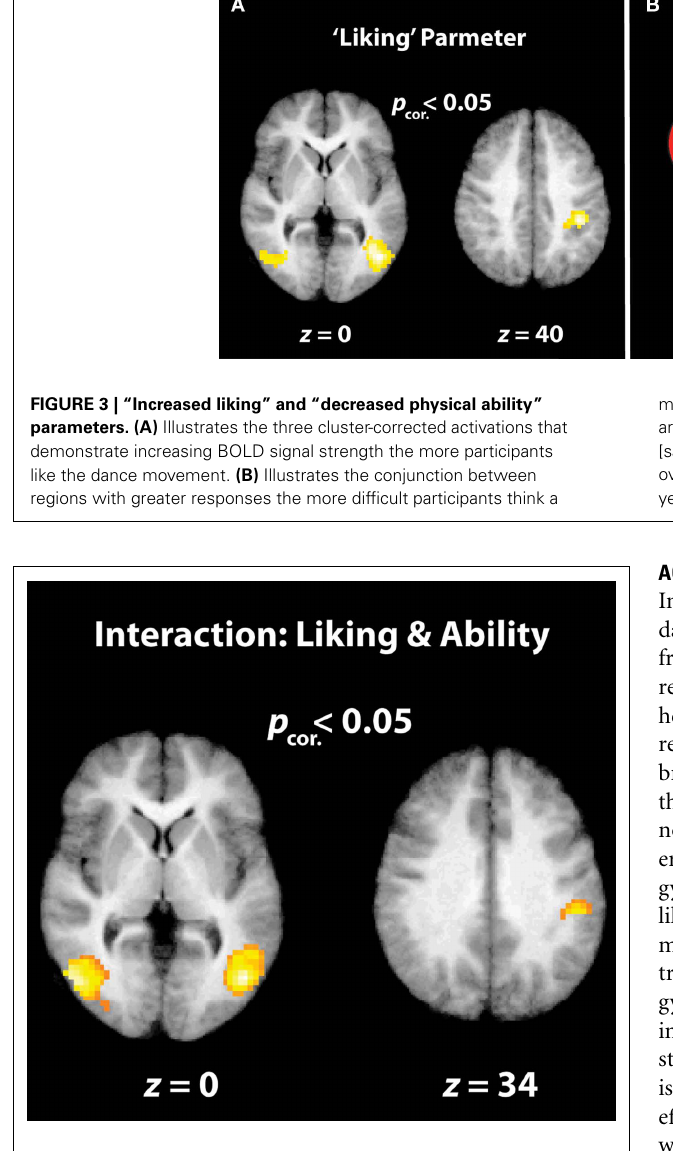
FIGURE 4 | Interaction between “liking” and “physical ability” parameters. The parietal and visual brain regions illustrated here are cluster-corrected activations that are active when participants watch dance movements that they rate as being highly enjoyable to watch, but very difficult to